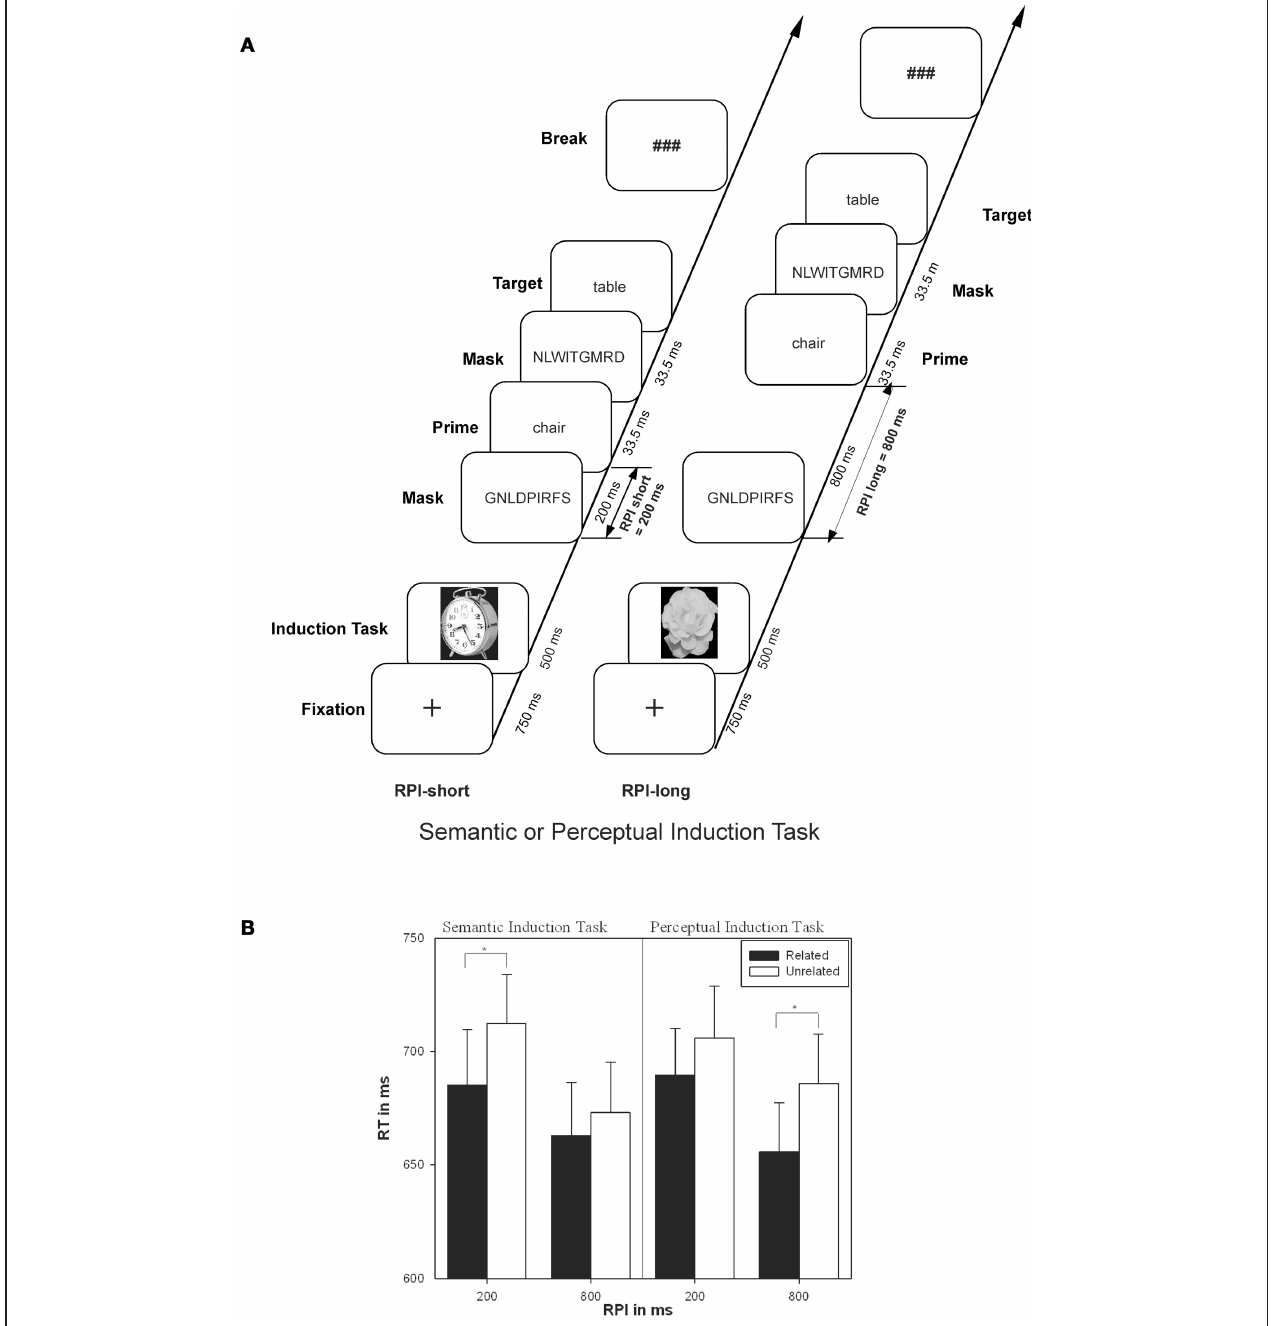
FIGURE 2 | (A) Induction task paradigm in combination with a masked semantic priming task. The masked prime word was presented either 200ms or 800ms following the response to the induction task (RPI). The semantic induction task required semantic classification (living/non-living decision) of the pictured object, whereas the perceptual induction task required a perceptual classification of the object (round/elongated shape). Subsequent to masked prime presentation, the target word was presented, which required a lexical decision (word/pseudoword). In the related priming condition, prime and target were semantically related (“table-chair”) whereas in the unrelated condition, prime and target were semantically unrelated (“hen-car”). (B) Behavioral semantic priming effects of Exp. 1 of the Martens